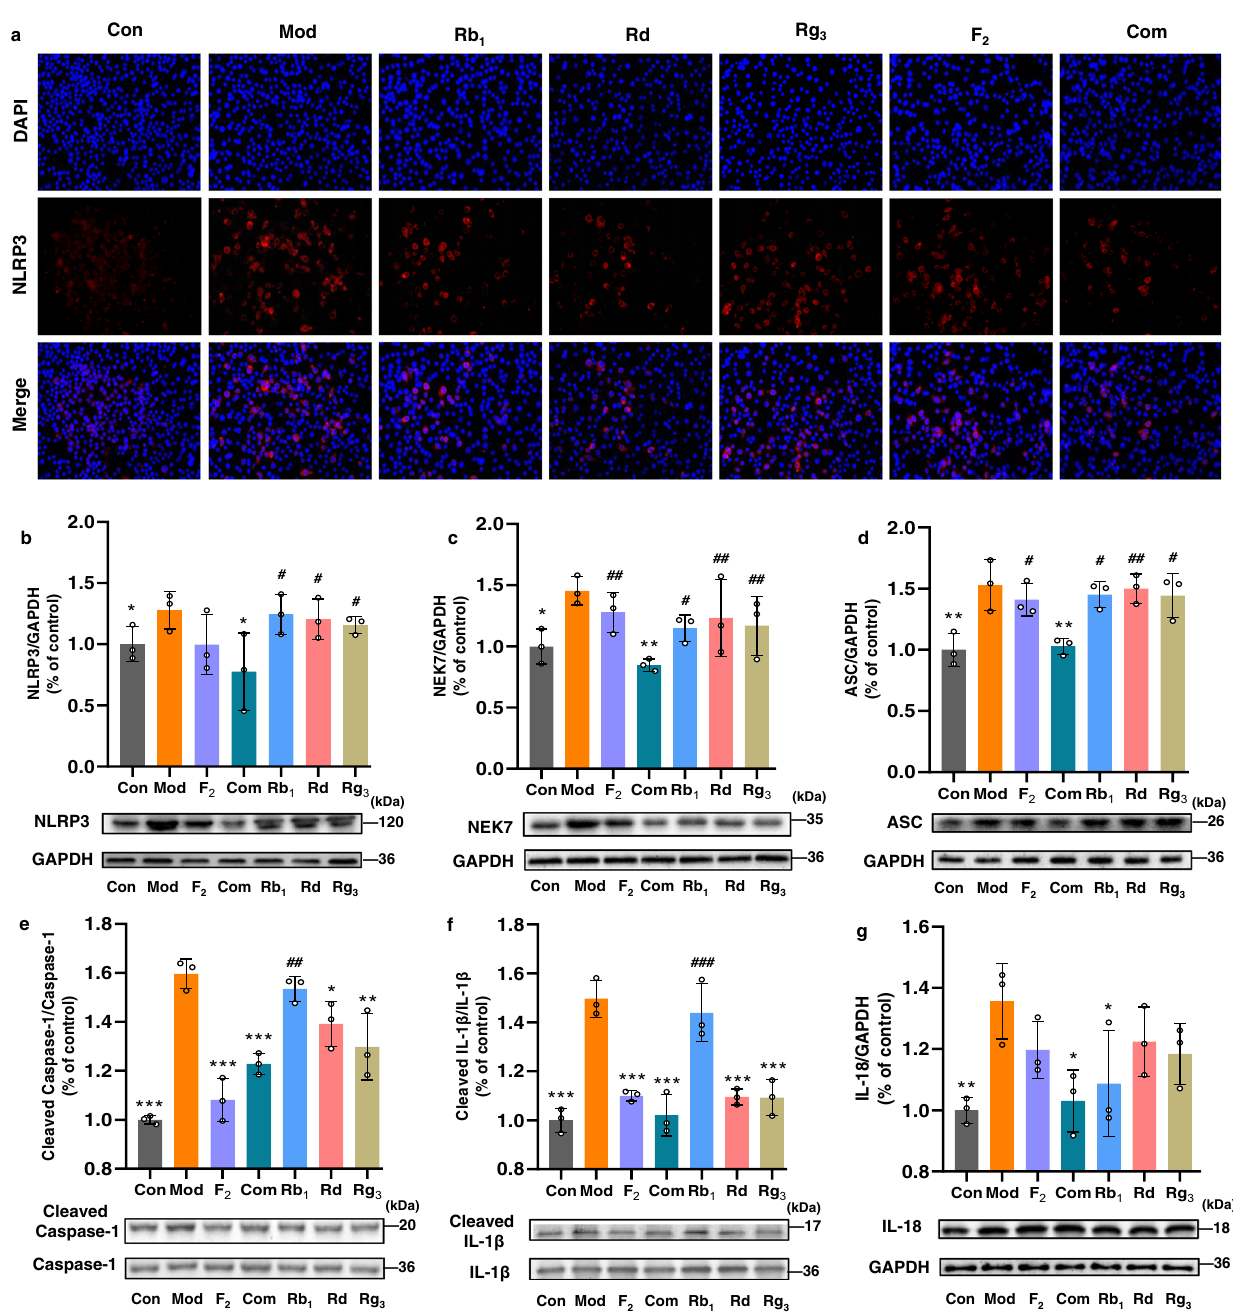
Fig. 5 The combination, but not individuals, signi fi cantly inhibits NLRP3 in fl ammasome activation in LPS/ATP-stimulated RAW264.7 macrophages. Immunostaining assay for activated NLRP3 ( a ) and western blot assay for determining protein expressions: b NLRP3, c NEK7, d ASC, e cleaved caspase-1/ caspase-1, f cleaved IL-1 β /IL-1 β , g IL-18 in cell lysates. GAPDH was used as the loading control. All data are expressed as mean ± SD ( n = 3). Compared with Mod, * P < 0.05, ** P < 0.01, *** P < 0.001; compared with Com, # P < 0.05, ## P < 0.01, ### P <